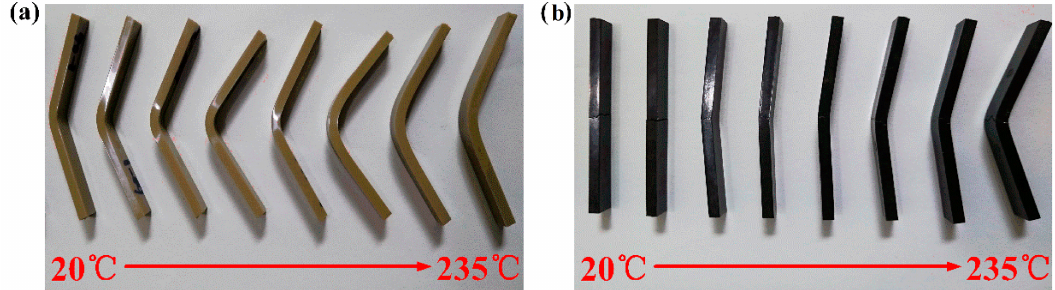
Figure 5. Flexural failure specimens of PEEK and SCFR/PEEK at various temperatures: ( a ) PEEK, ( b ) SCFR/PEEK.